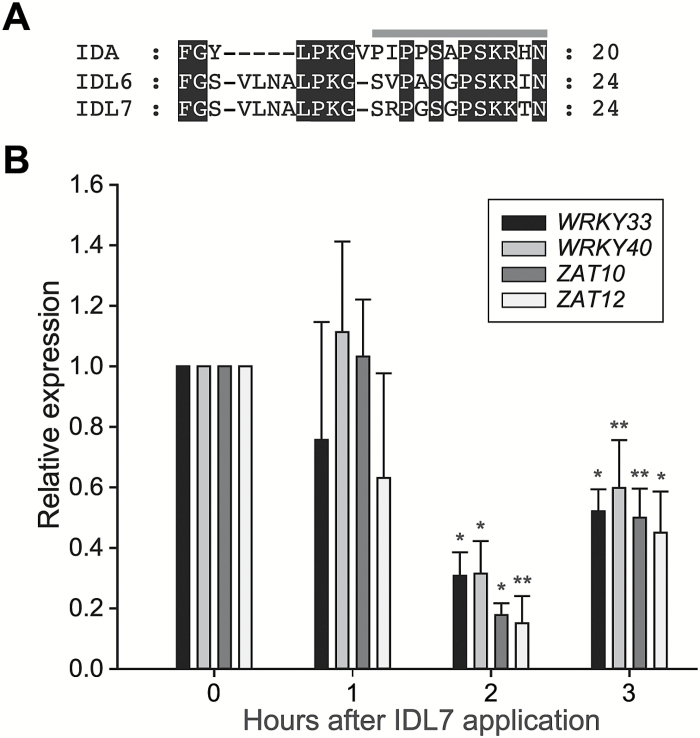
IDL7 negatively affects the expression of stress-related genes. (A) Alignment of the EPIP peptides from IDA, IDL6, and IDL7. The grey bar above the alignment indicates the PIP peptide. (B) Effect of the IDL7-EPIP peptide on gene expression of the transcription factor genes WRKY33, WRKY40, ZAT10, and ZAT12 over time. Statistical differences (REST analysis: *P-value <0.05; **P-value <0.01) between samples treated with MOCKIDL7 and IDL7 peptide (100 nM) are indicated (n=3). Error bars indicate SDs.